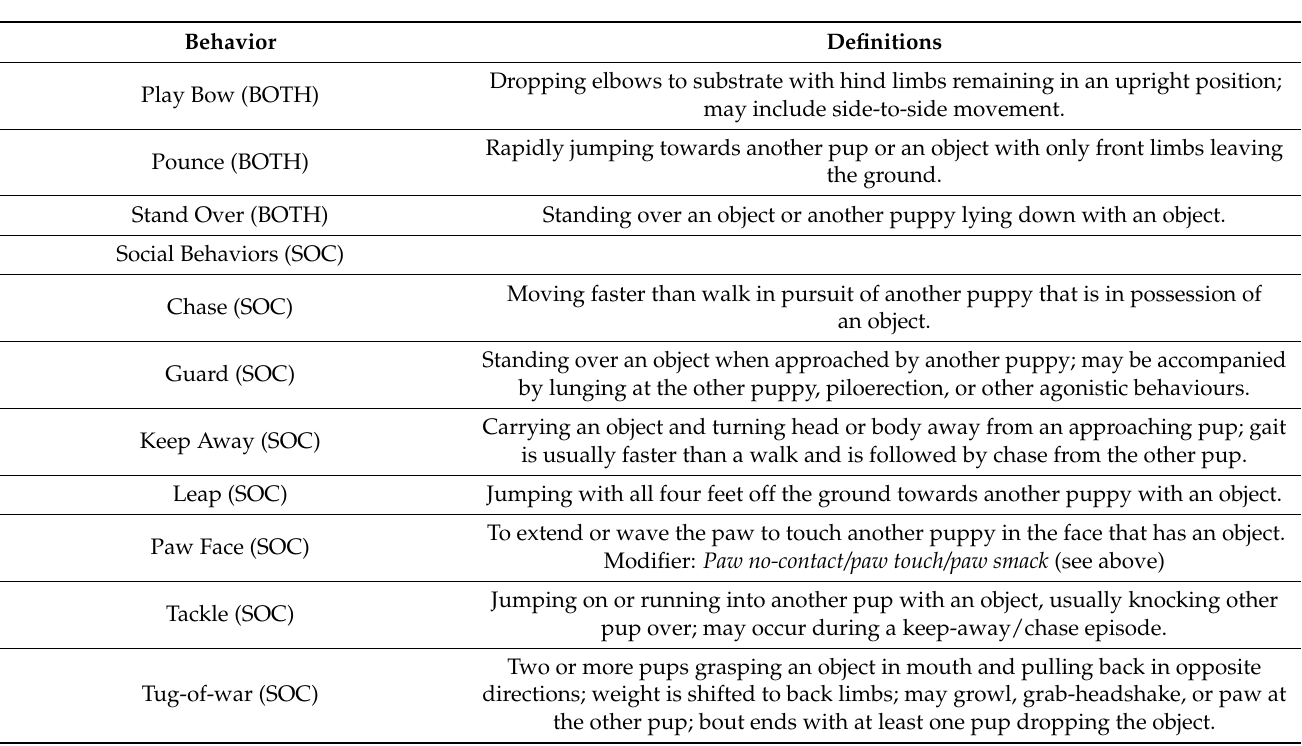
Table 2. Observed behaviors not included in play data coding or analysis. (A) Vocalizations